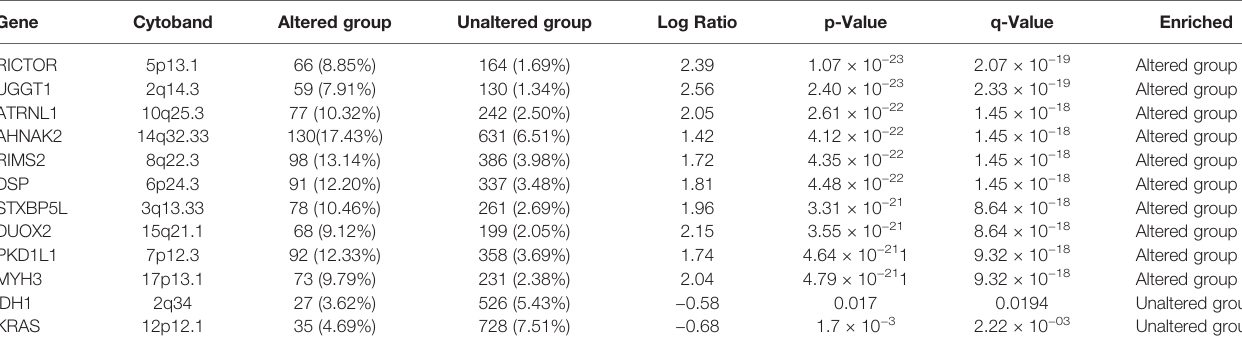
TABLE 2 | Enriched genes in EGFR altered and Unaltered cohorts across the cbioportal